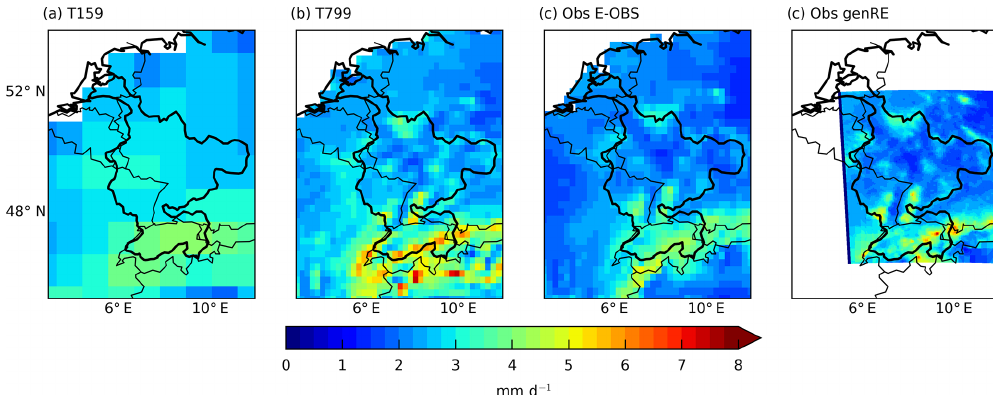
Figure 4. 30-year average of daily precipitation sums (mmday − 1 ) over the Rhine basin for (a) the low-resolution EC-Earth simula- tions (T159), (b) the high-resolution EC-Earth simulations (T799), (c) the E-OBS dataset (Obs E-OBS), and (d) the genRE precipitation dataset (Obs